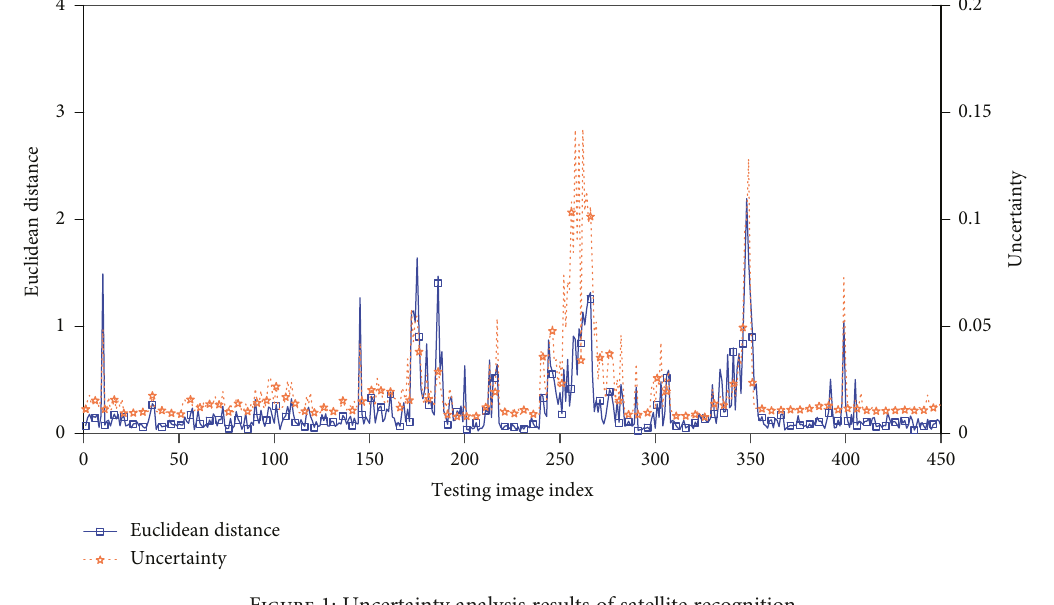
Figure 1: Uncertainty analysis results of satellite recognition.